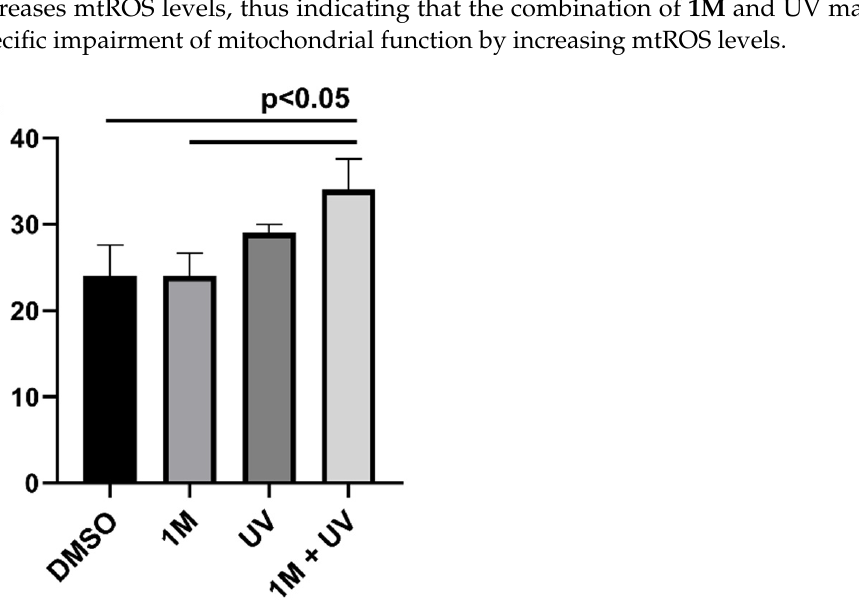
Figure 13. A combination of 1 µ M 1M and UV light irradiation increases mtROS in A549 cells. The experiments were performed at least three times and representative data are shown. p < 0.05, 1M +UV irradiation vs. DMSO and 1M . Results are presented as mean ± SD.